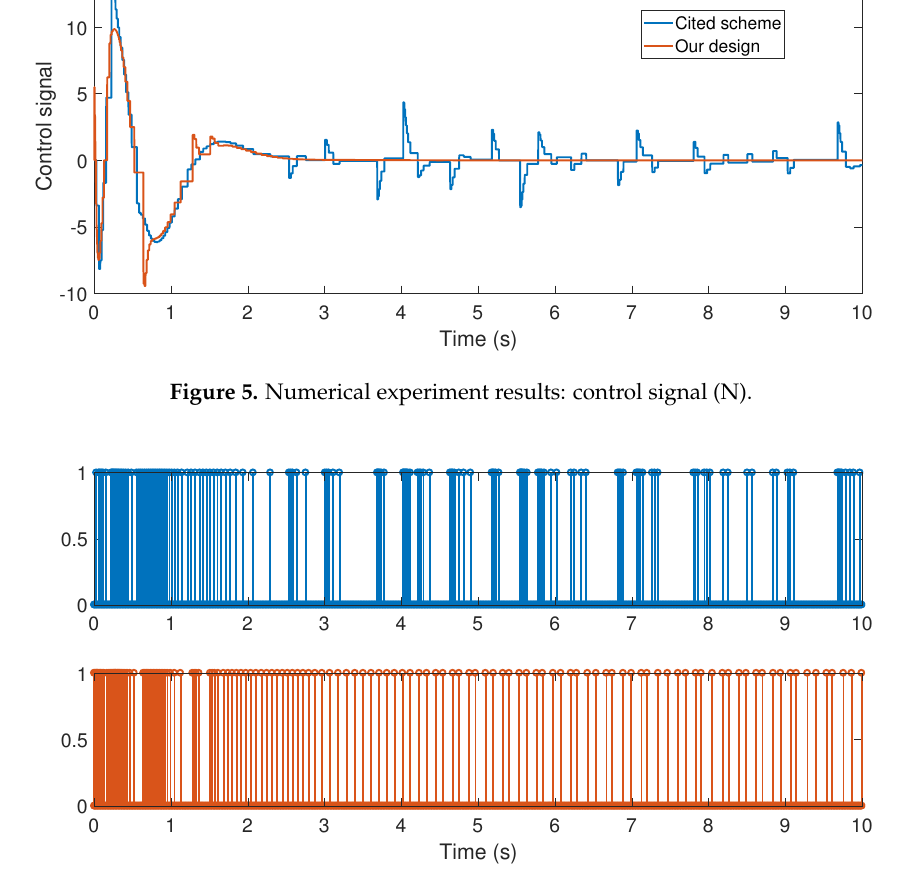
Figure 6. Numerical experiment results: sampling instants; top corresponds to the cited reference case and bottom to our design method.